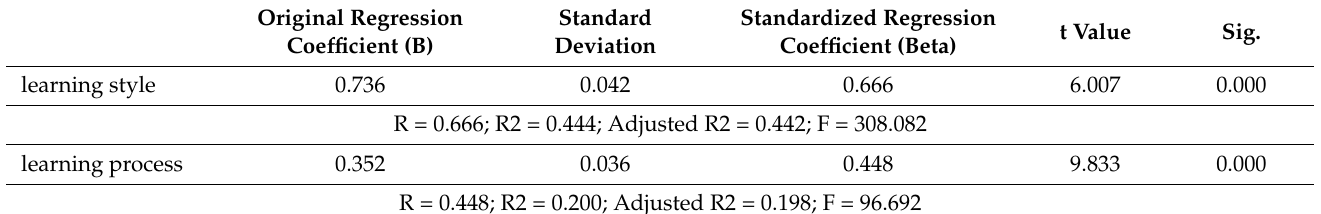
Table 4. Regression